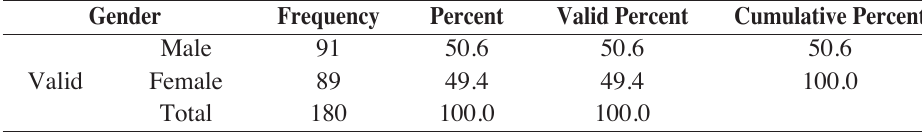
Table 2. Gender of Respondents